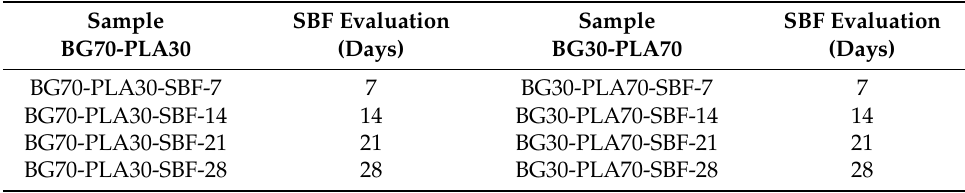
Table 1. Identification of samples evaluated in SBF.